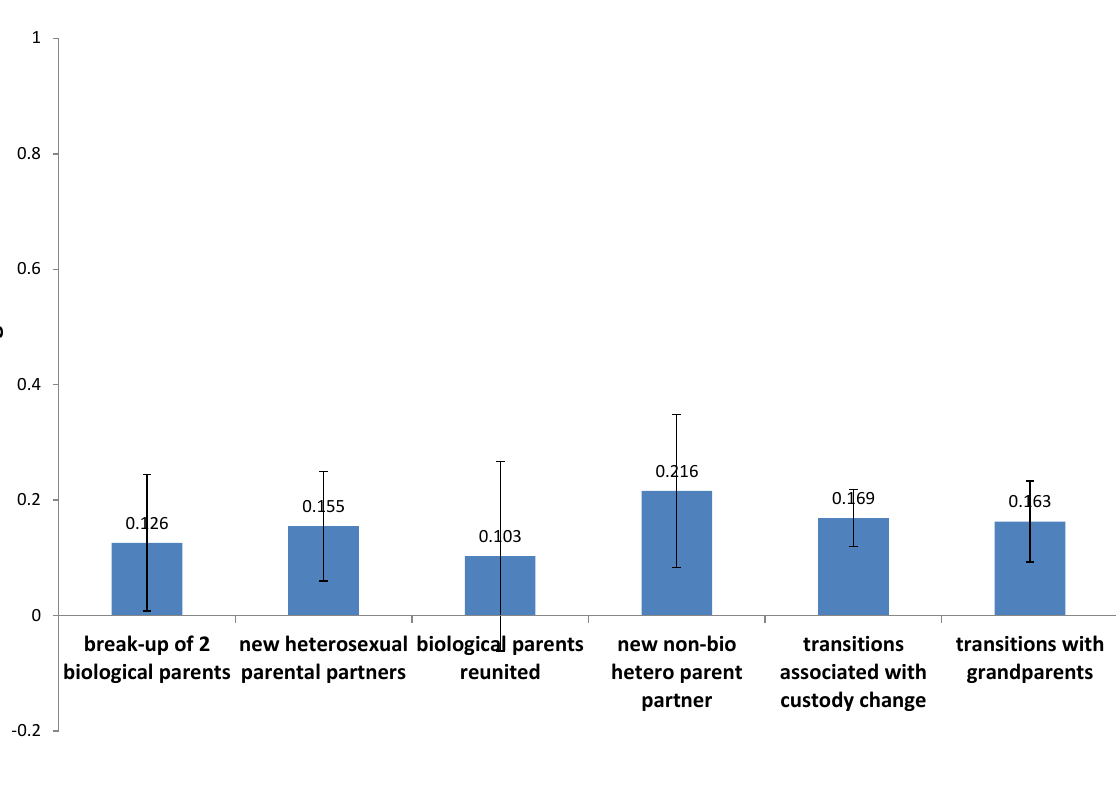
Figure 2: Different Types of Family Transitions as Predictors of the Standardized Negative Outcome Index, with 95% Confidence Intervals Data Source: NFSS. Coefficients from OLS regressions are weighted by variable “weight4” as the probability weight, with robust standard errors, N = 2,466 ∗ P < 0.05; ∗∗ P < 0.01; ∗ ∗ ∗ P < 0.001, two-tailed